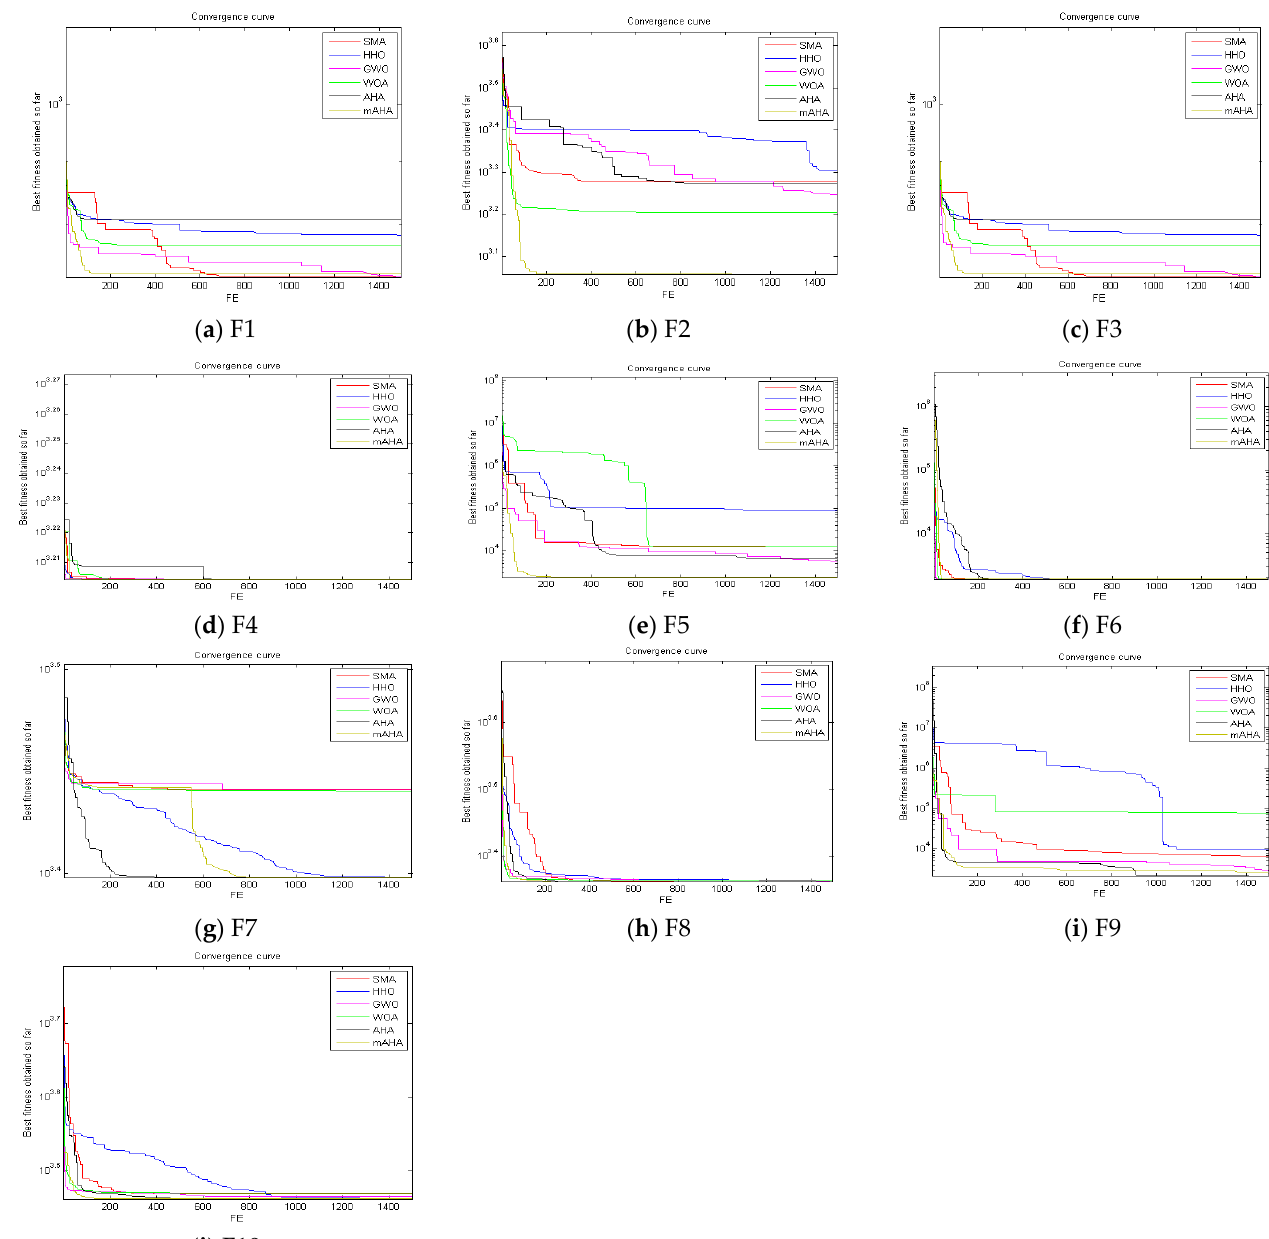
Figure 1. The convergence curves on the CEC’20 test suite have been obtained by the proposed mAHA and the competitor algorithms for 30 runs with Dim10.